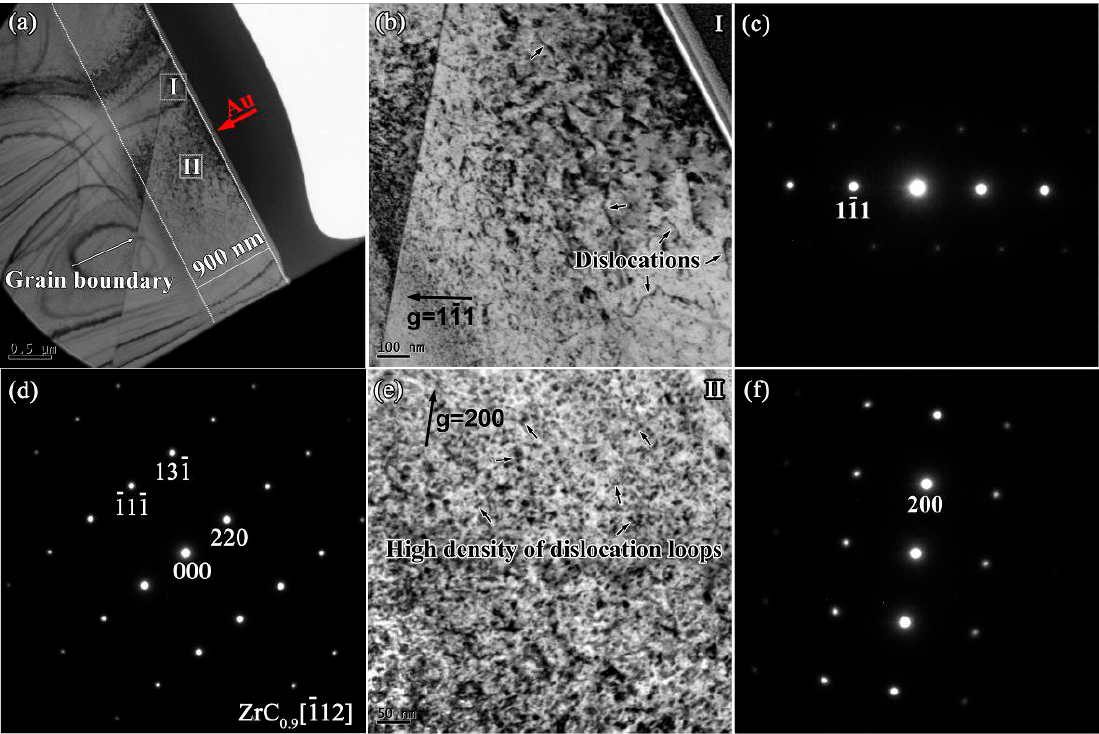
Figure 7. ( a ) Cross-section BF-TEM images of ZrC 0.9 after irradiation; ( b ) BF image of irradiated ZrC 0.9 at Region I taken from ( c ) a two-beam condition diffraction pattern with g = 11 — 1 near the zone axis [011]; ( d ) SAED patterns obtained from the zone axis [1 — 12] of the damaged area; ( e ) BF image of irradiated ZrC 0.9 at region II taken from ( f ) two-beam condition diffraction pattern with g = 200 near zone axis [001].